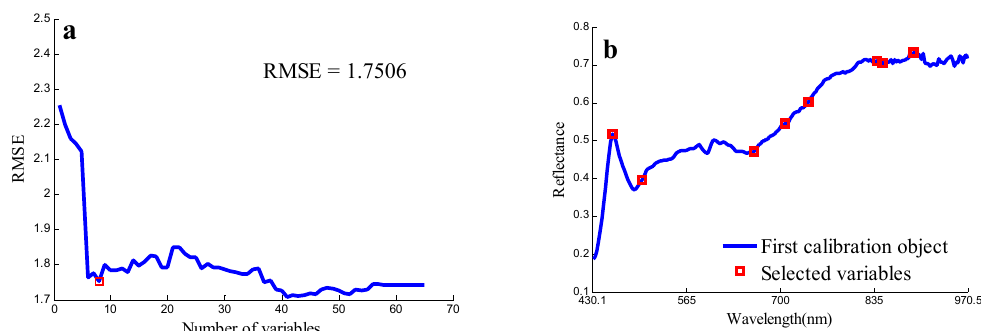
Figure 5. The RMSE plot ( a ) and selected wavelengths (shown in red square marker) by SPA ( b ). RMSE: root mean square error. SPA: successive projection algorithm.